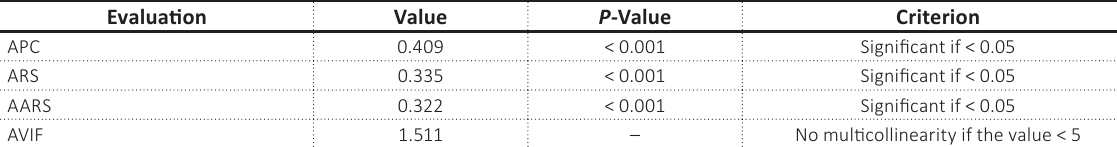
Table 2. Goodness of fit of the model